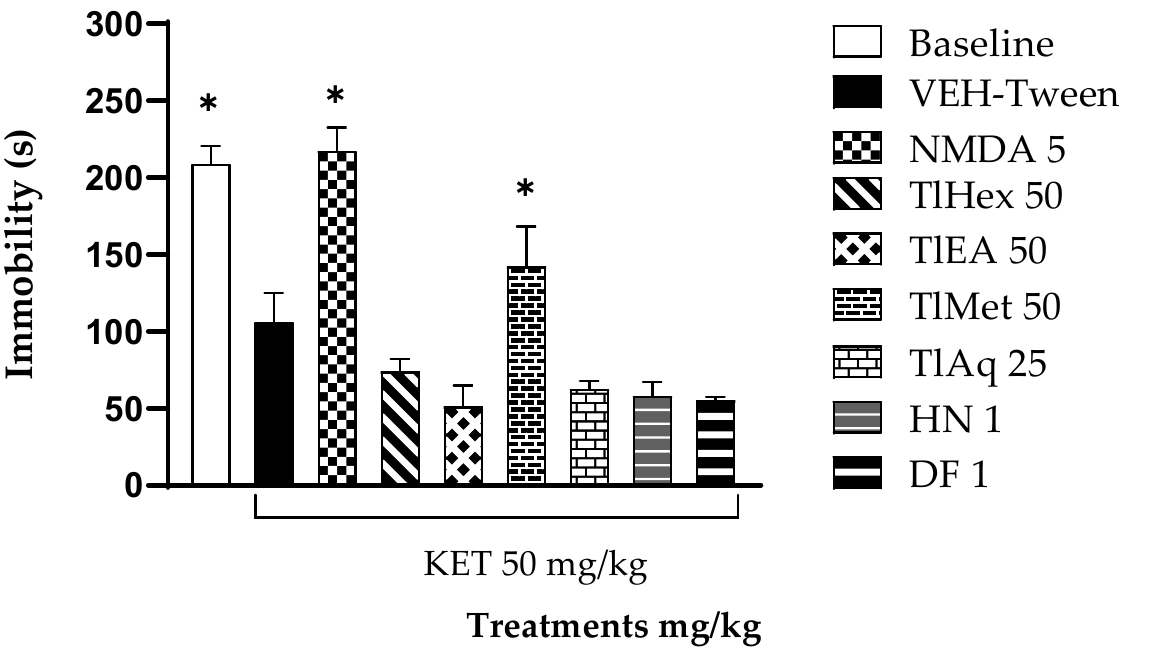
Figure 5. Effect of T. lucida extracts, herniarin (HN), and dimethylfraxetin (DF) on acute schizophrenia-like symptoms induced with KET 50 mg/kg i.p., in the Forced Swimming Test (FST) in mice. ANOVA followed by Dunnett’s Test ( ± S.E.M., n = 5) with * p < 0.05 when the comparison is with the VEH-Tween group.